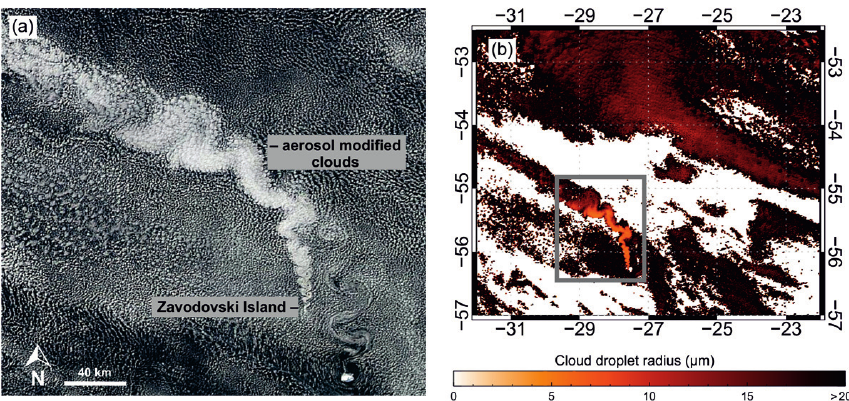
Fig. 1. Satellite retrievals showing that volcanic emissions from Mount Curry volcano on Zavodovski Island (South Sandwich Islands in the Southern Ocean) modified cloud properties and albedo resulting in brighter clouds than the surrounding clouds. (a) Natural-colour image acquired 27 April 2012 by the Moderate Resolution Imaging Spectroradiometer (MODIS) on NASA’s Aqua satellite; and (b) cloud droplet effective radius at the top of the clouds calculated from MODIS data. Underlying MODIS image and data provided by Robert B. Simmon, NASA Earth Observatory, and Jeff Schmaltz, LANCE MODIS Rapid Response